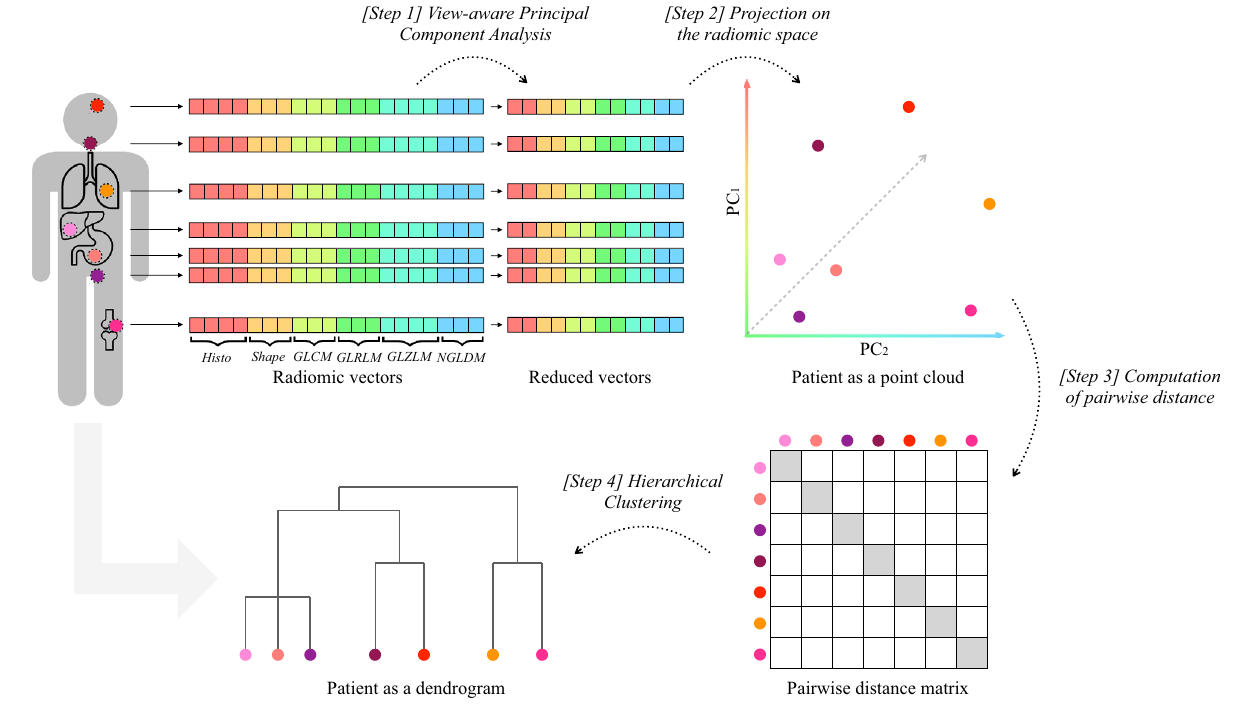
Figure 1. Patient representation pipeline: lesions’ radiomic vectors of each patient are dimensionally reduced according to view-aware Principal Component Analysis. [Step 1] Features are grouped according to the six semantic group, or view , they are semantically divided into. As to preserve a balanced importance between views, two principal components are kept from the scores of each PCA, leading to different percentages of explained variability. A total of twelve principal components results from the process, which include six orthogonal pairs of linear combinations of original features. [Step 2] Accordingly, patients are represented as finite sets of n i points in R 12 , that is the reduced radiomic space according to view-aware strategy implementation. In the example, n i = 7 . [Step 3] Pairwise (Euclidean) distance is computed among patients’ lesions and [Step 4] hierarchical clustering with average linkage is applied to distance matrices, resulting in a dendrogram T representing each